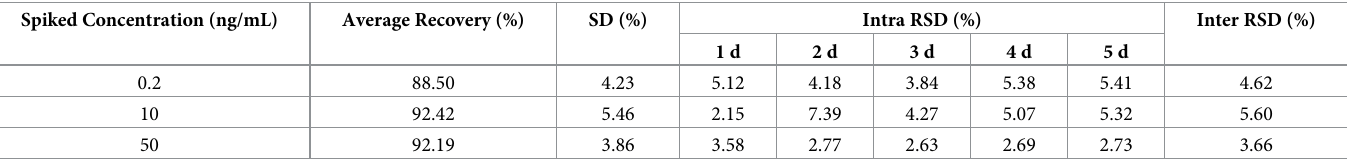
Note: SD, standard deviation; RSD, relative standard deviation.